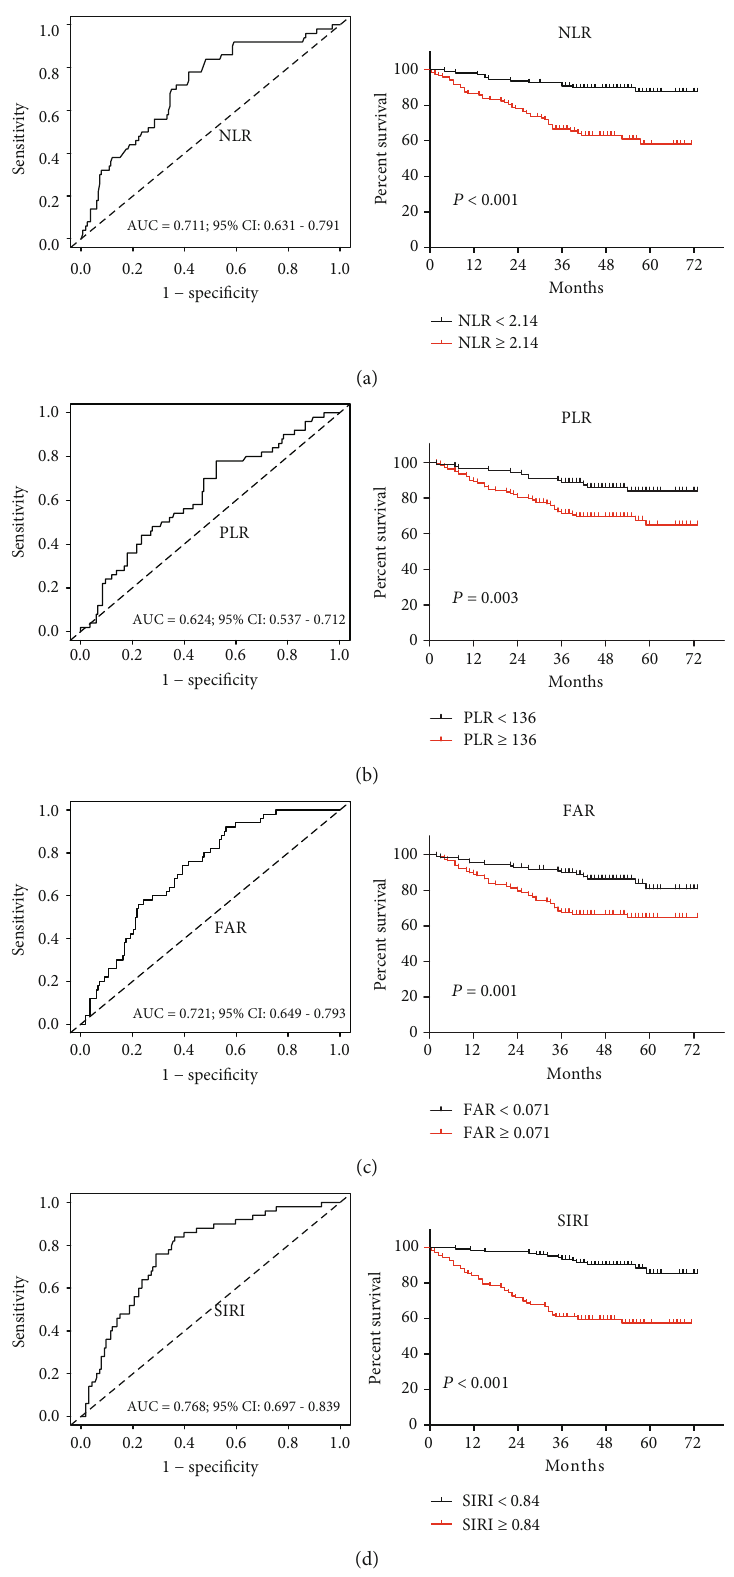
Figure 2: Receiver operating characteristic curve (ROC) analyses of optimal cuto ff s and survival analysis for (a) NLR, (b) PLR, (c) FAR, and (d) SIRI in patients with GC. NLR: neutrophil-lymphocyte ratio; PLR: platelet-lymphocyte ratio; FAR: fi brinogen-albumin ratio; SIRI = N × M/L , where N, M, and L represent the preoperative counts of neutrophils, monocytes, and lymphocytes, respectively. Kaplan-Meier survival analysis with the log-rank test was used to calculate P